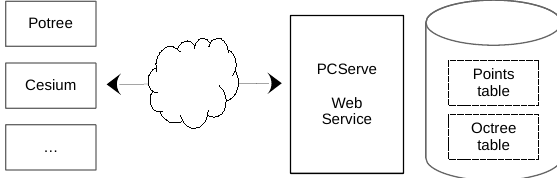
Figure 2. SQL create table statement for the points table. Note, that the SFC key we used is a partial resolution key, containing Figure 4. PCServe, the web service component, retrieves points an approximation for the position and importance level of the from the database by joining the octree and points table based on points. the SFC keys (points) and SFC ranges